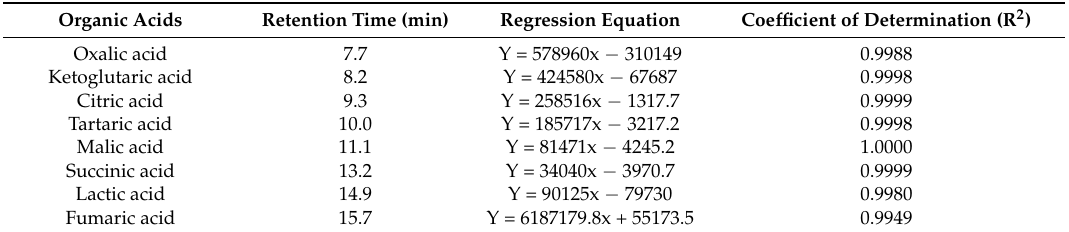
Table 1. Retention times and regression equation of organic acids separated by HPLC analysis. Organic